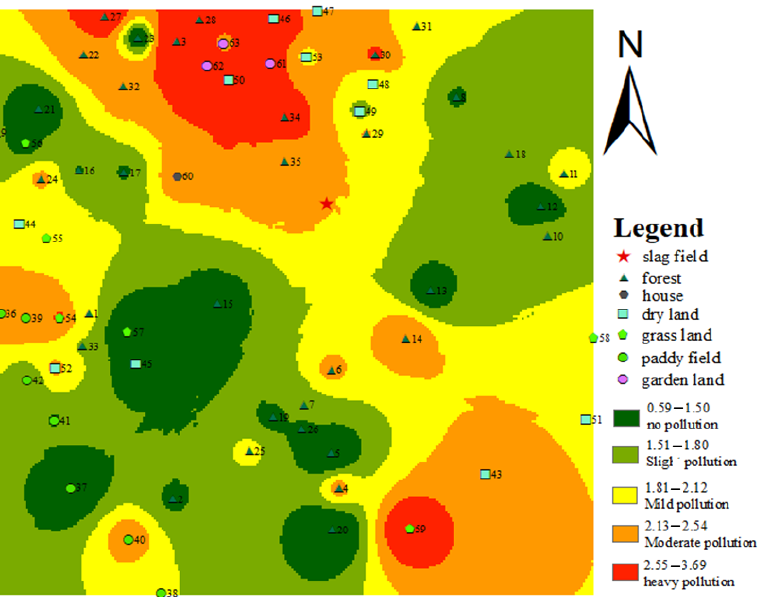
Figure 3. Spatial distribution layer of comprehensive pollution evaluation of soil heavy metals.